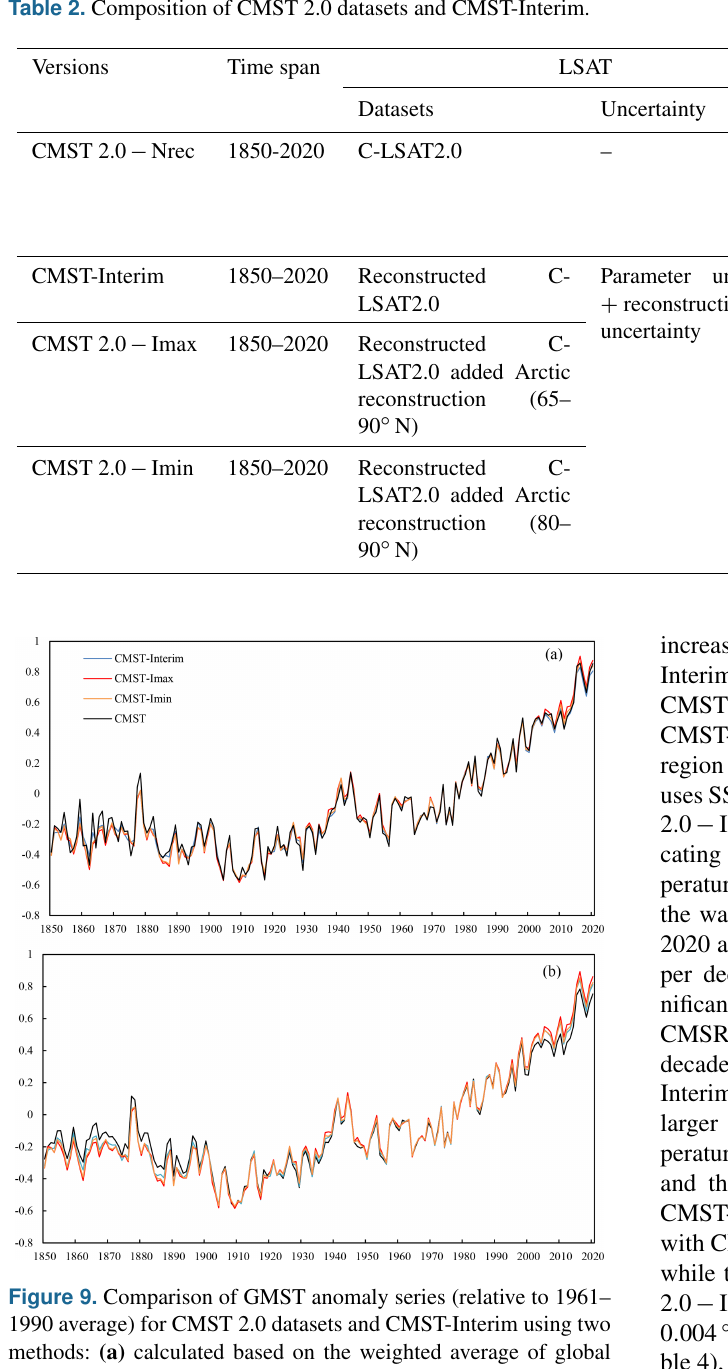
Table 2. Composition of CMST 2.0 datasets and CMST-Interim.